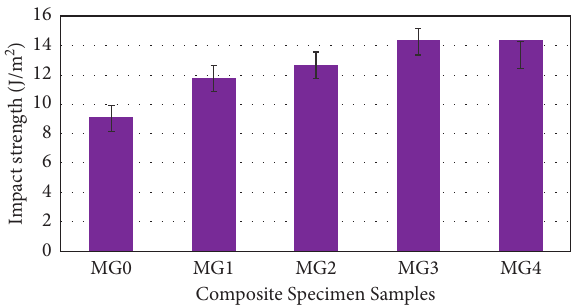
Figure 12: Variation on impact strength of composite